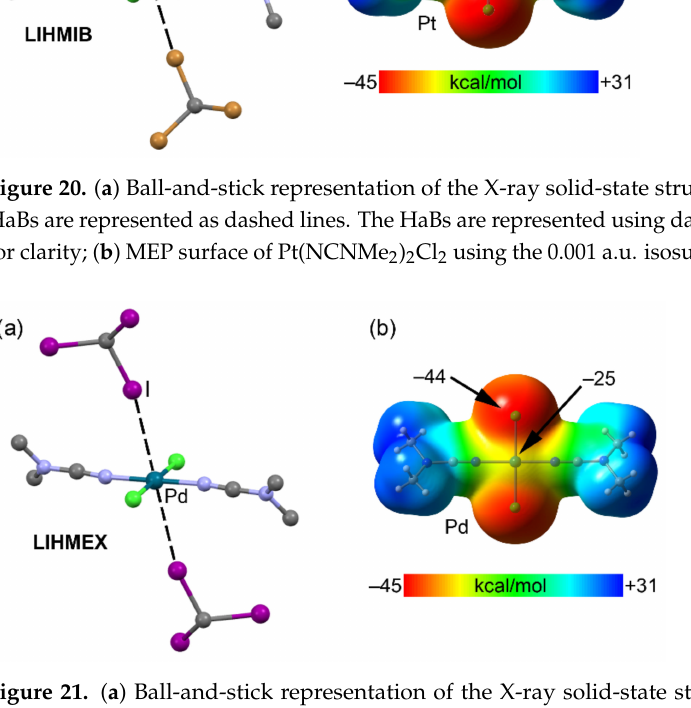
Figure 21. ( a ) Ball-and-stick representation of the X-ray solid-state structure of LIHMEX, where the HaBs are represented using dashed lines. H atoms omitted for clarity; ( b ) MEP surface